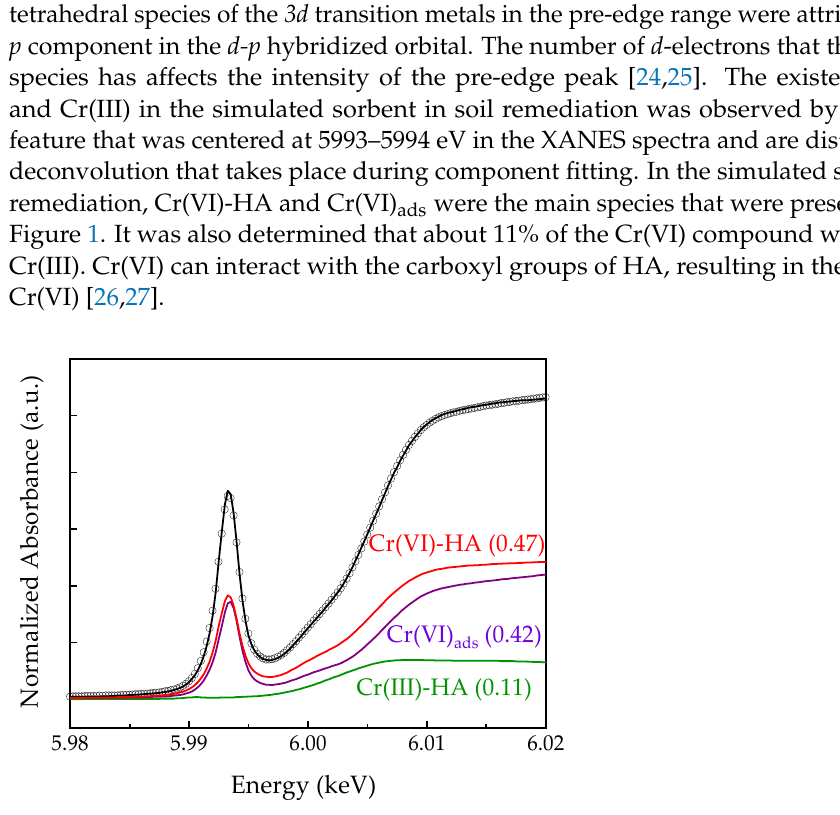
Figure 1. The least-square fitted XANES spectra of chromium in